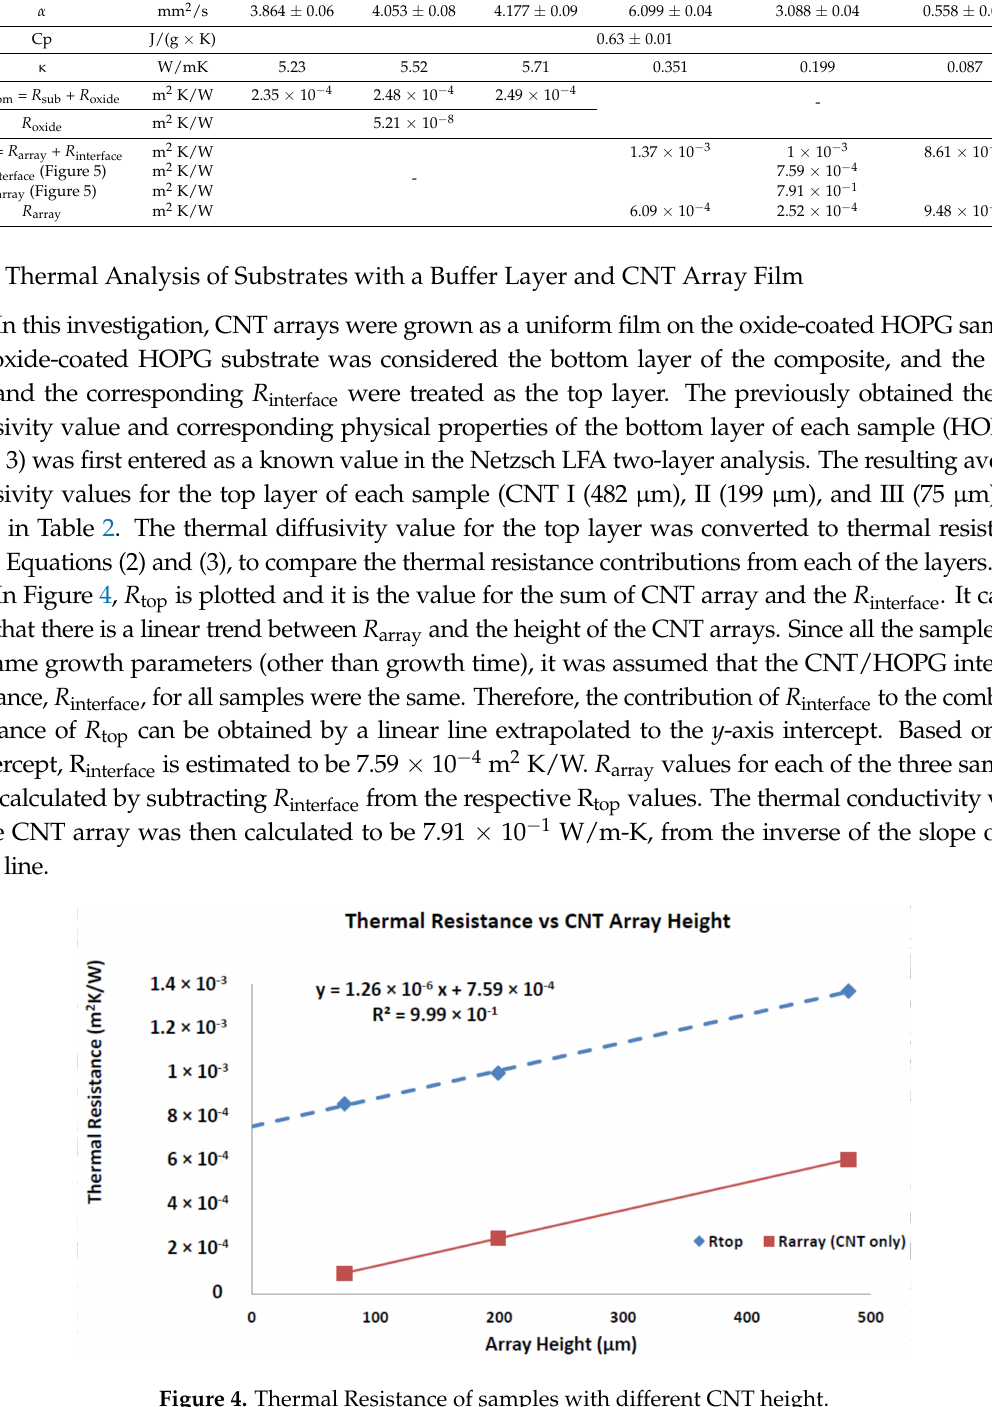
Figure 4. Thermal Resistance of samples with different CNT